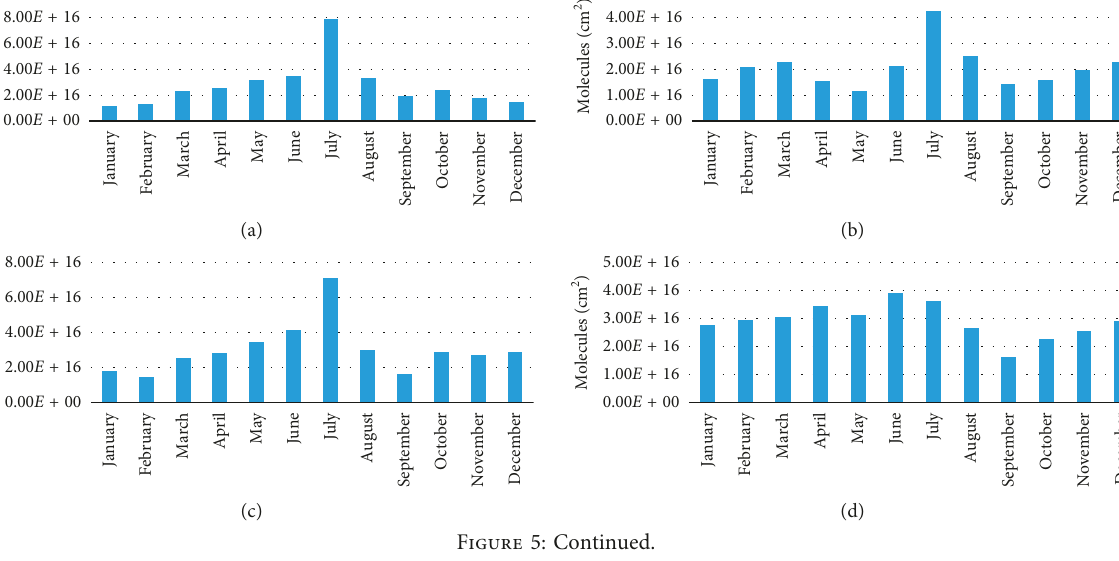
002.00 E 0.00 E +